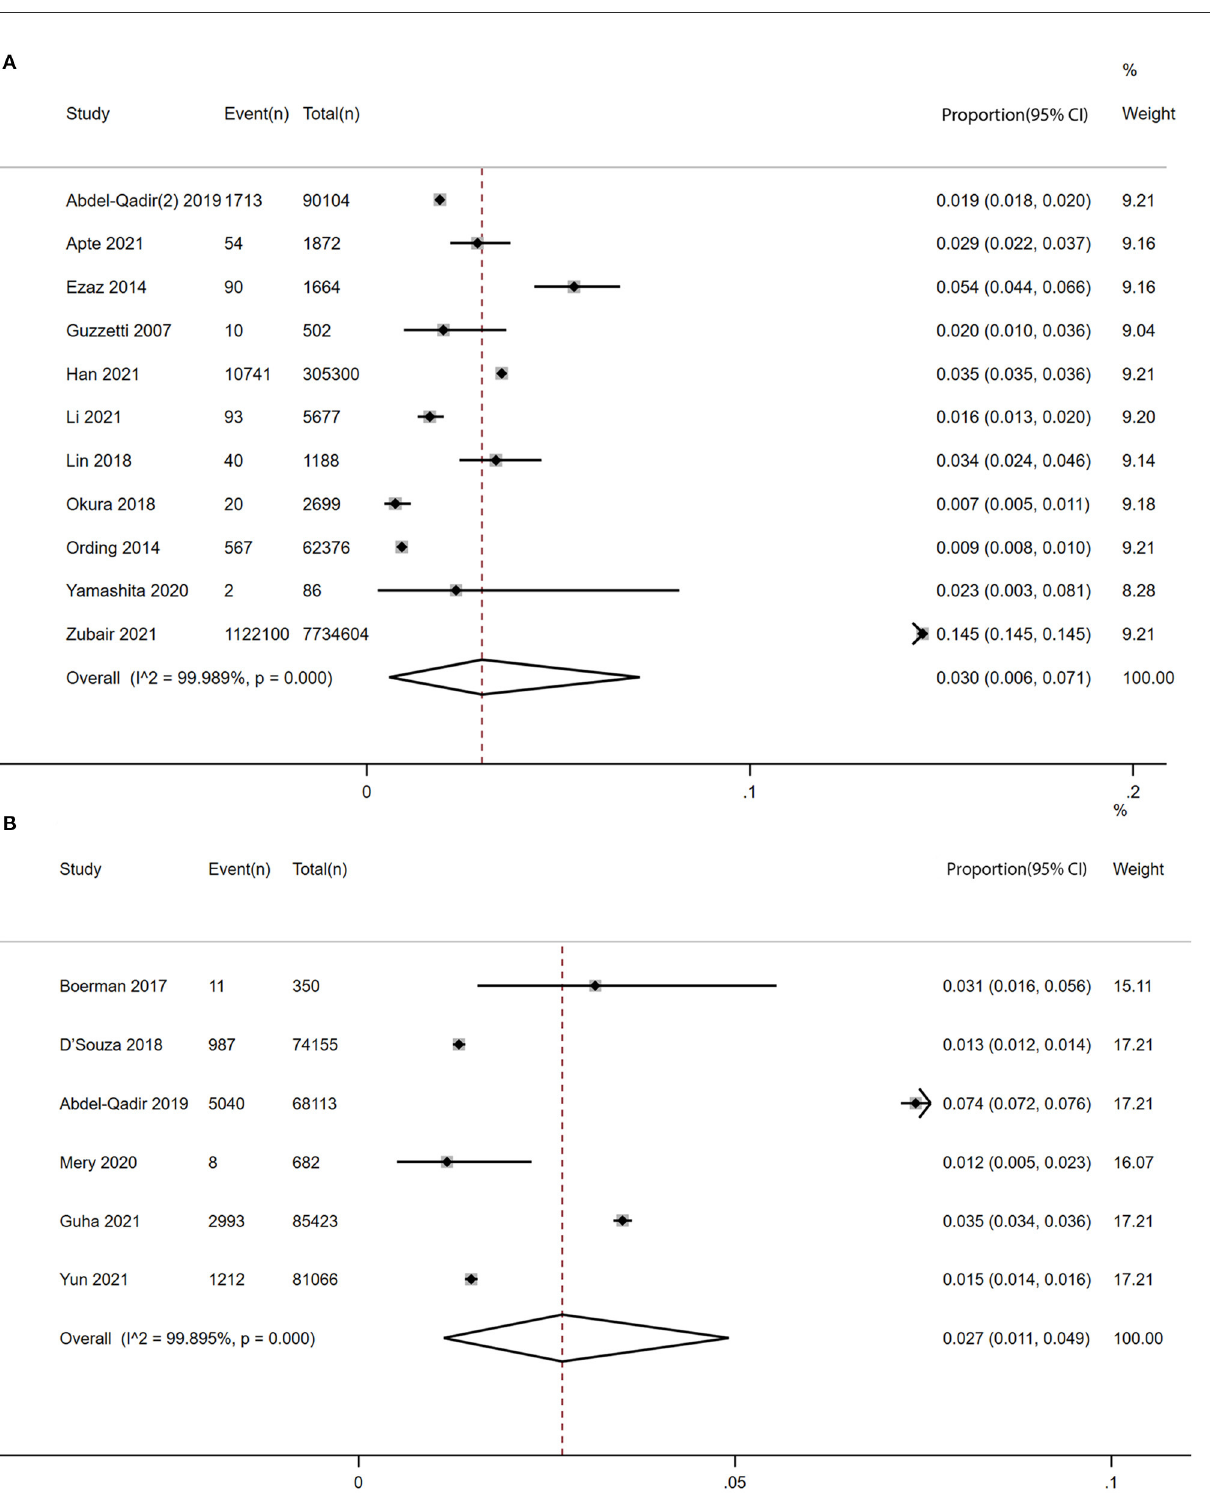
FIGURE2 Forest plot of prevalence and incidence of AF in patients with BC [ (A) prevalence vs. (B) incidence]. Inside the forest plot, the rhombus indicates the pooled estimate. Black squares and black vertical lines indicate 95%CIs around the effect size estimate. AF, atrial fibrillation; BC, breast cancer.